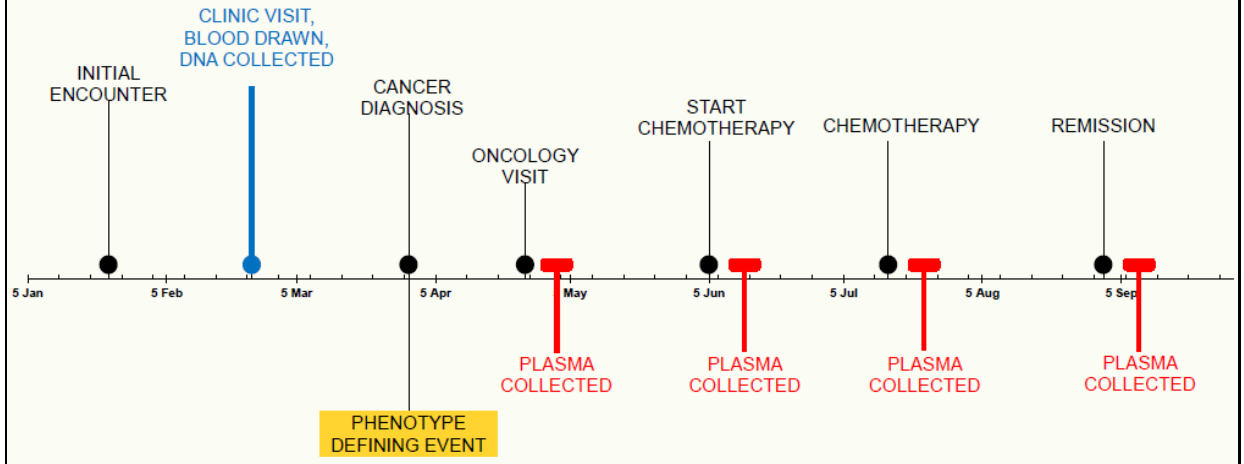
Figure 3. Example timeline of DNA and plasma parallel collection. BioVU DNA banking occurs in a defined moment in the medical timeline of a patient. DNA acquisition may be before, after or during diagnosis of a particular disease state. In contrast, phenotypic events trigger specific plasma collection, opening the possibility for observation throughout the varying phases of their clinical